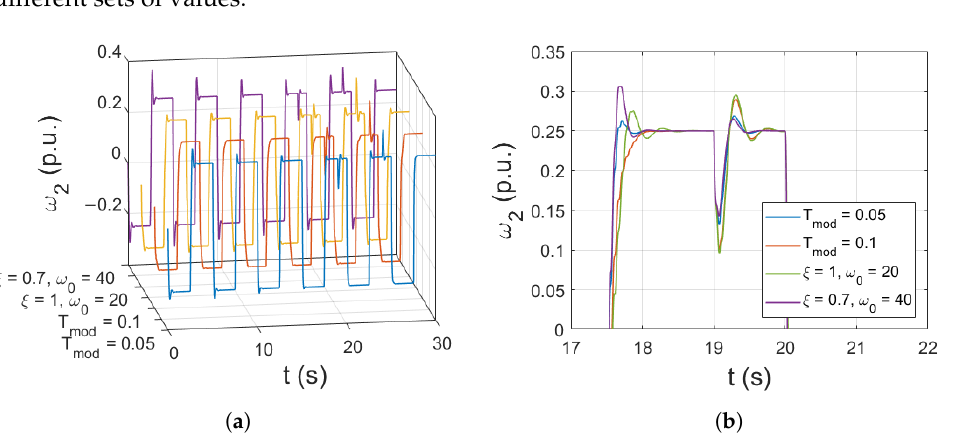
Figure 12. Comparison of the load speed for different reference signal filters ( a ), zoom of the selected part of simulation ( b